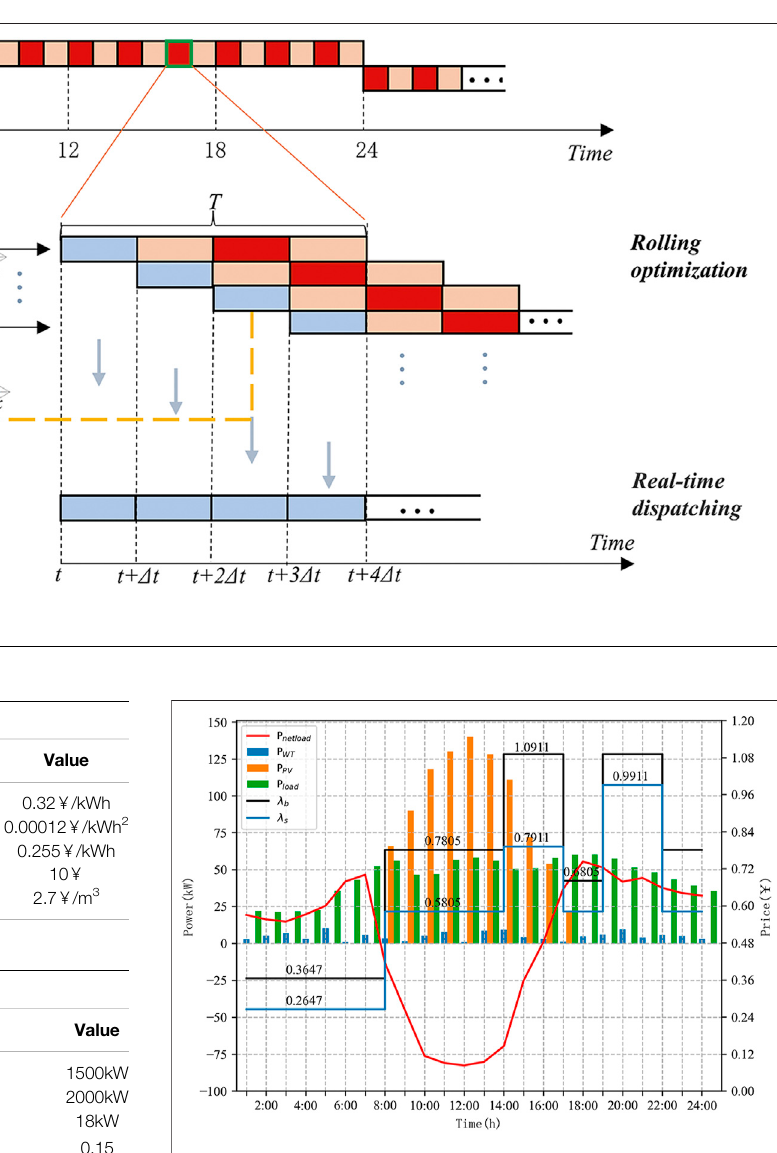
FIGURE 4 | Net electric load and electricity